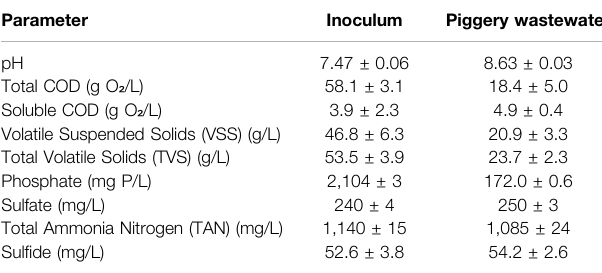
TABLE 1 | Characteristics of the inoculum and substrate used in this study.